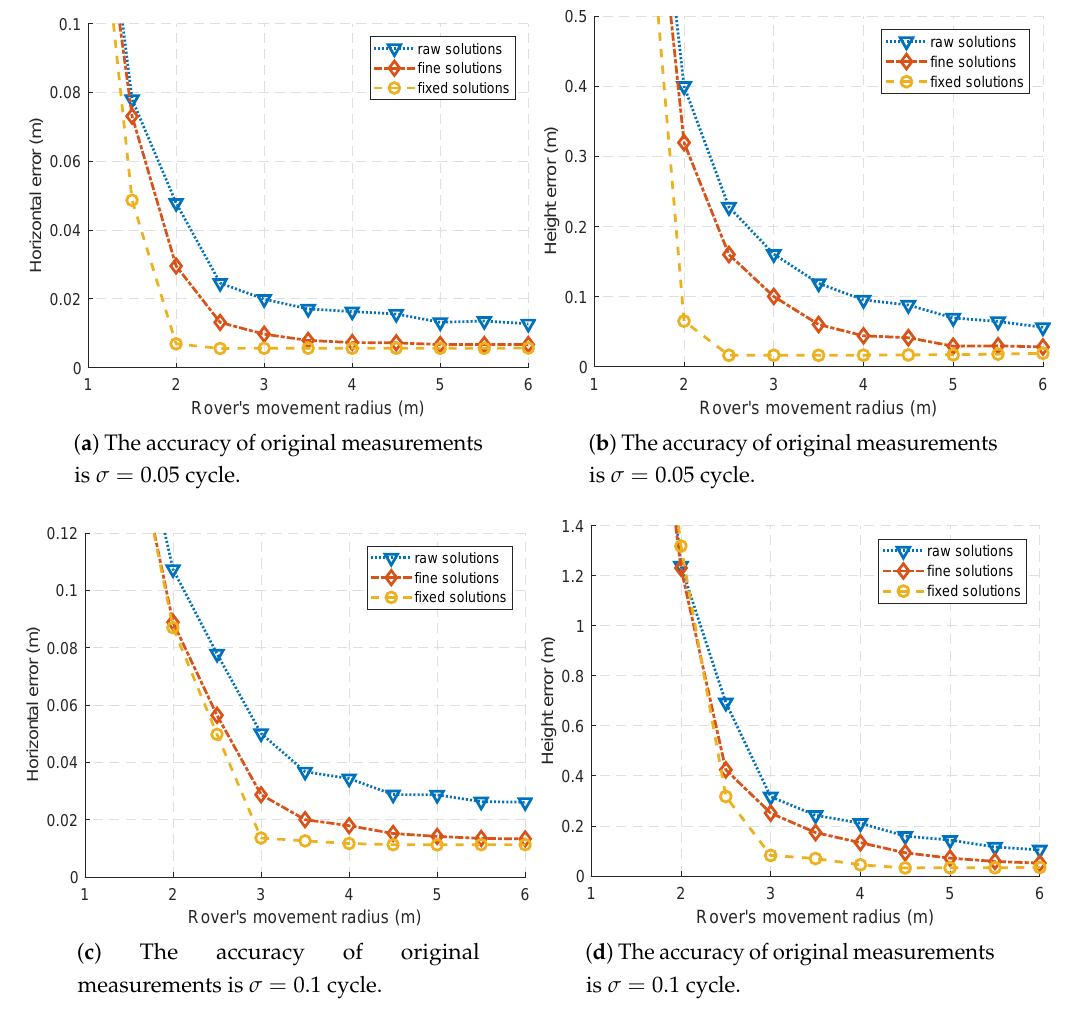
Figure 4. The rover’s movement radius R is increased from 1 m to 6 m, and the results with R < 2 m are rather bad and not conducive to